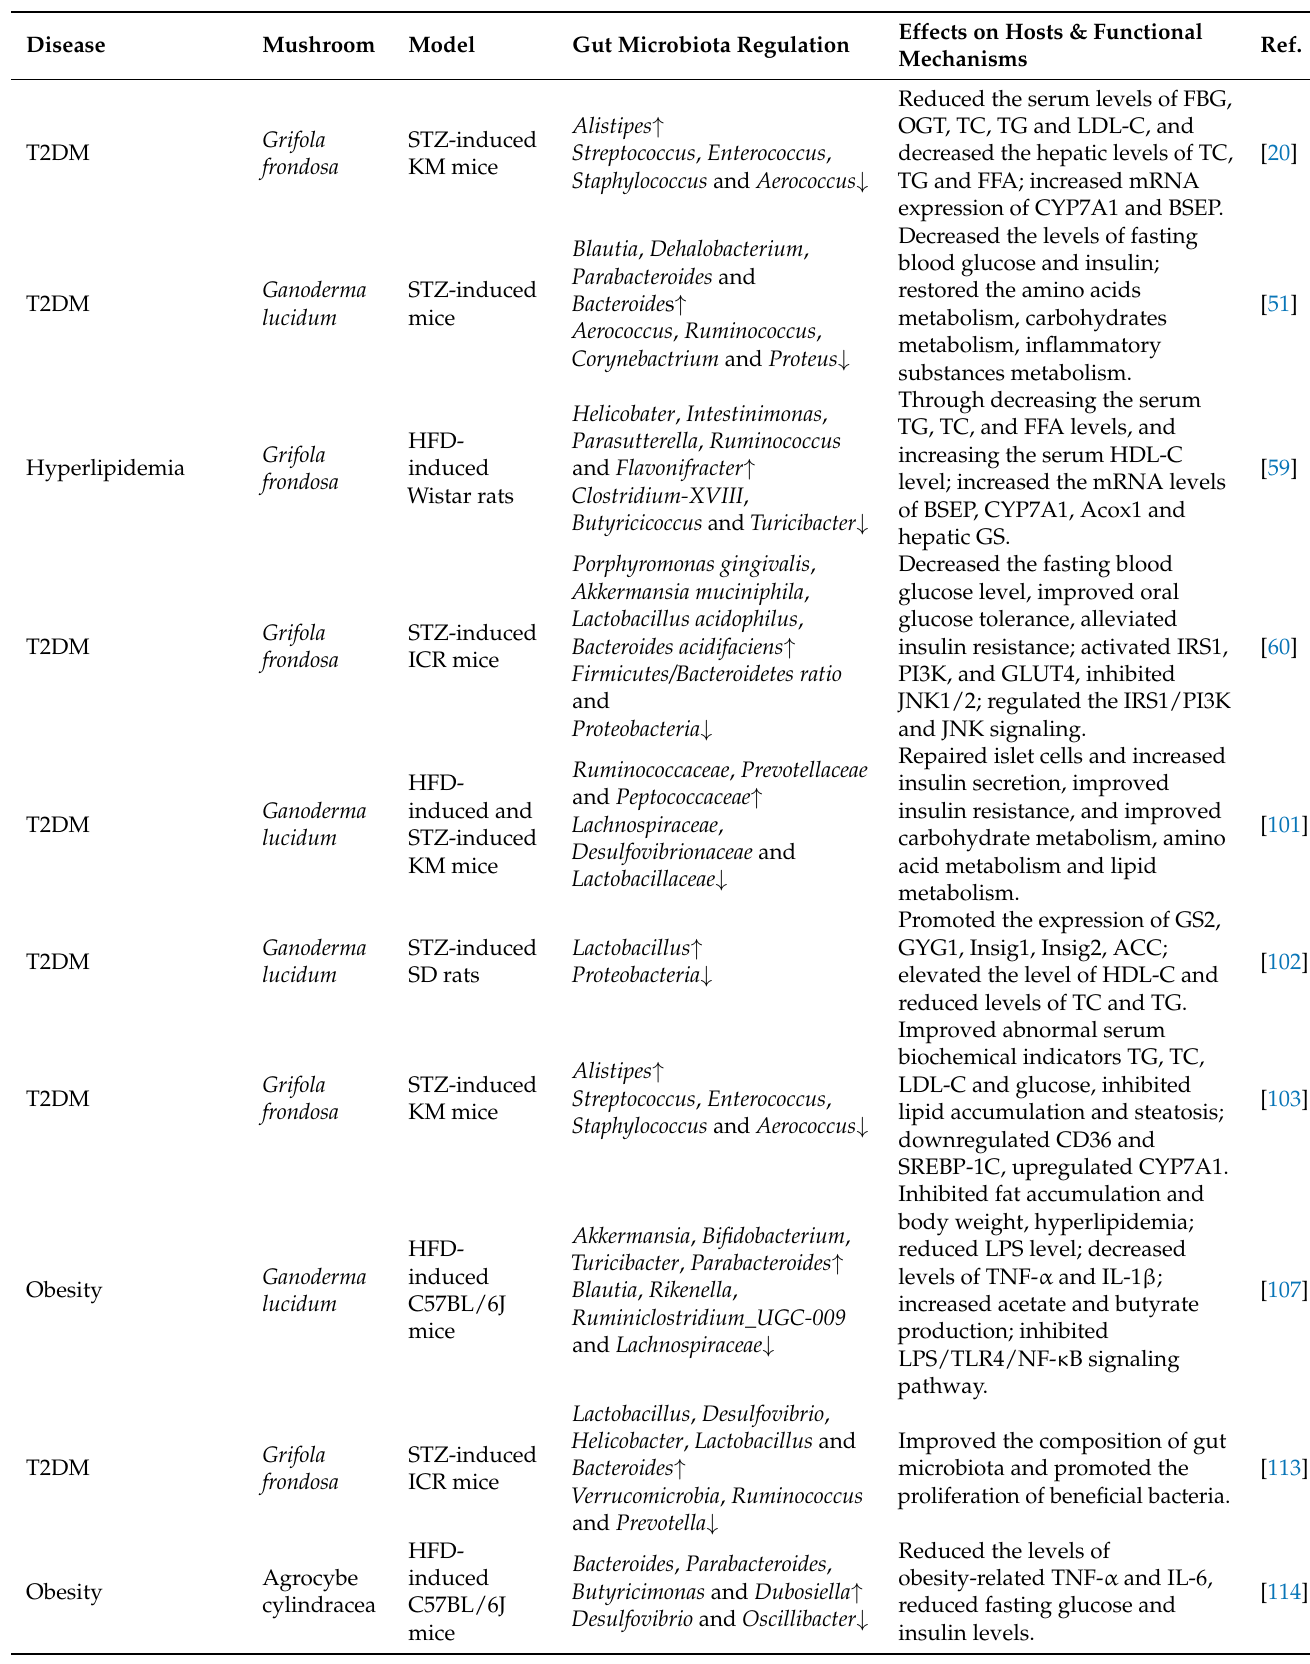
Table 2. The modulation of gut microbiota in metabolic disorders by mushroom polysaccharides.